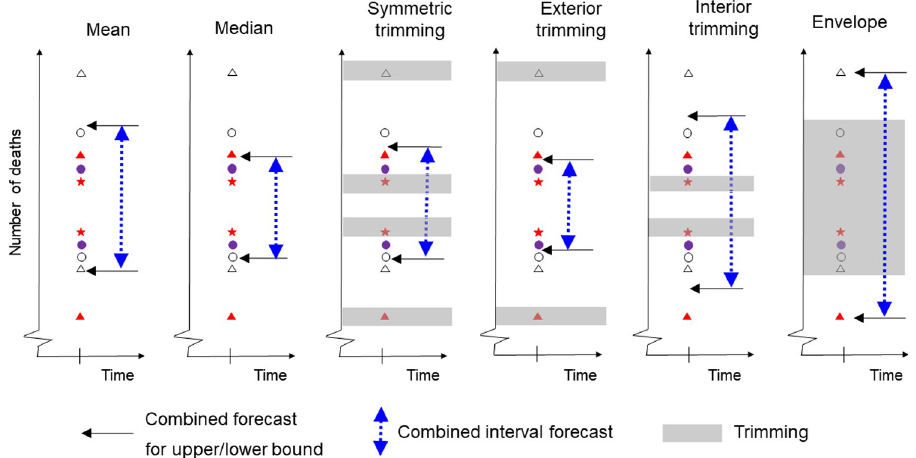
Fig 3. Illustration of interval forecast combining methods that do not rely on past historical accuracy. Each pair of shapes represents an interval forecast produced by an individual model.